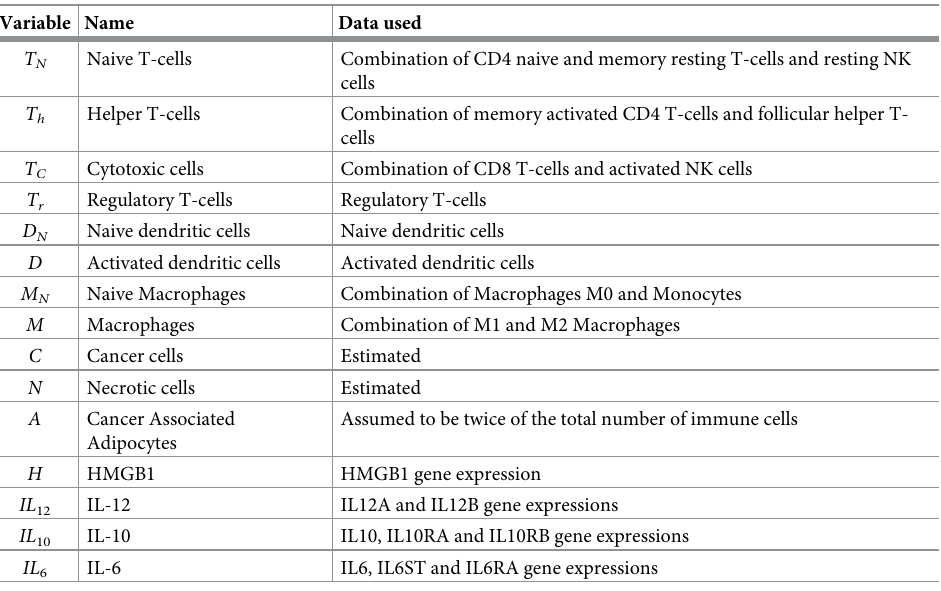
Table 1. Mouse data correspondence with variables. Variable Name Data used T N Naive T-cells Combination of CD4 naive and memory resting T-cells and resting NK cells T h Helper T-cells Combination of memory activated CD4 T-cells and follicular helper T- cells T C Cytotoxic cells Combination of CD8 T-cells and activated NK cells T r Regulatory T-cells Regulatory T-cells D N Naive dendritic cells Naive dendritic cells D Activated dendritic cells Activated dendritic cells M N Naive Macrophages Combination of Macrophages M0 and Monocytes M Macrophages Combination of M1 and M2 Macrophages C Cancer cells Estimated N Necrotic cells Estimated Assumed to be twice of the total number of immune cells A Cancer Associated Adipocytes H HMGB1 HMGB1 gene expression IL 12 IL-12 IL12A and IL12B gene expressions IL 10 IL-10 IL10, IL10RA and IL10RB gene expressions IL 6 IL-6 IL6, IL6ST and IL6RA gene expressions Correspondence between the model variables and the gene expression data of the primary tumors and deconvolution